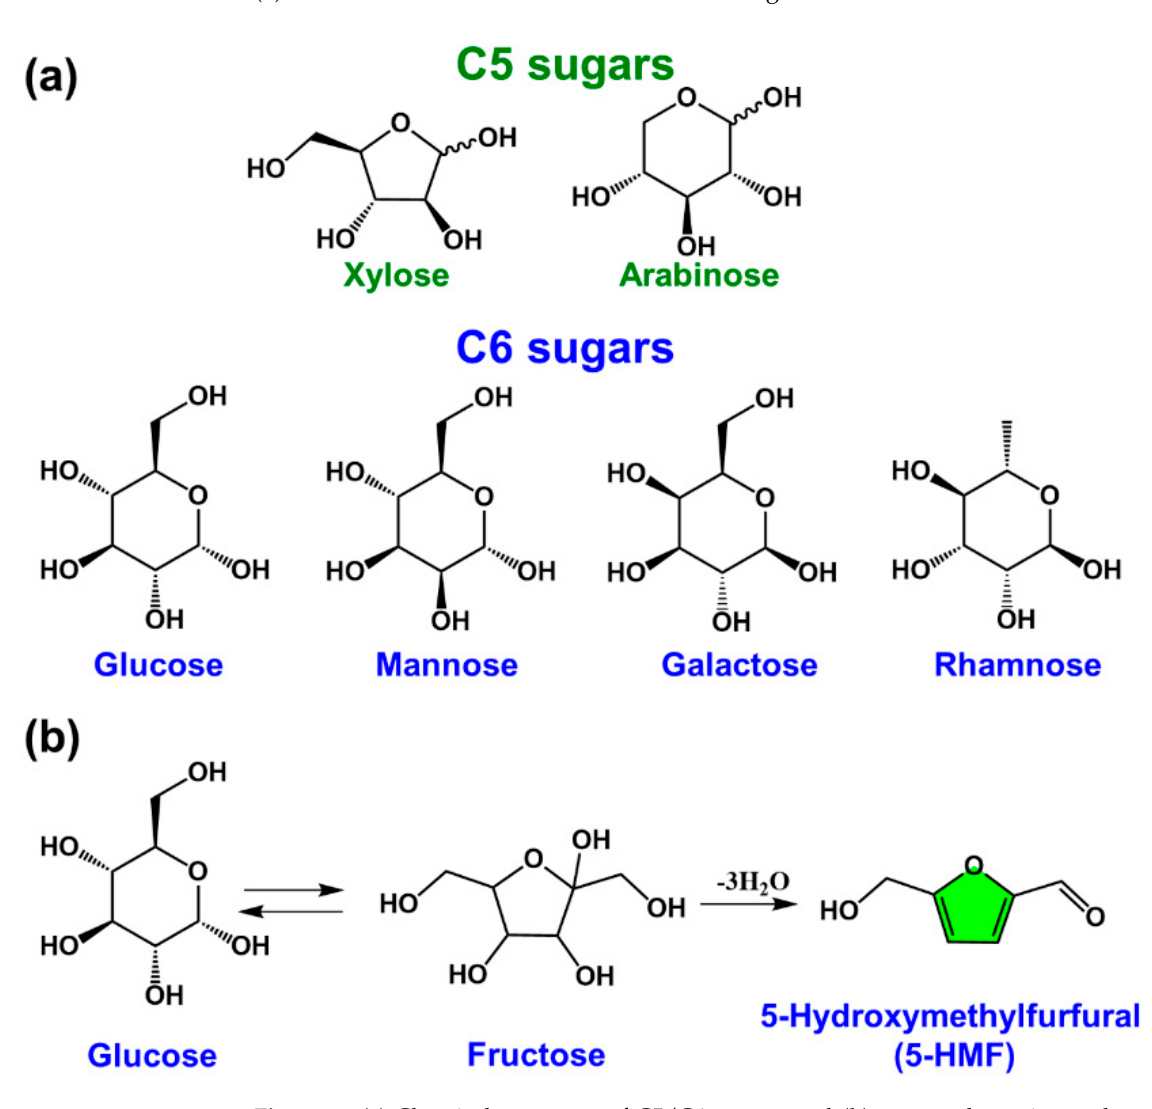
Figure 3. ( a ) Chemical structures of C5/C6 sugars, and ( b ) a general reaction pathway for the preparation of 5 − hydroxymethylfurfural by the dehydration reaction of glucose.